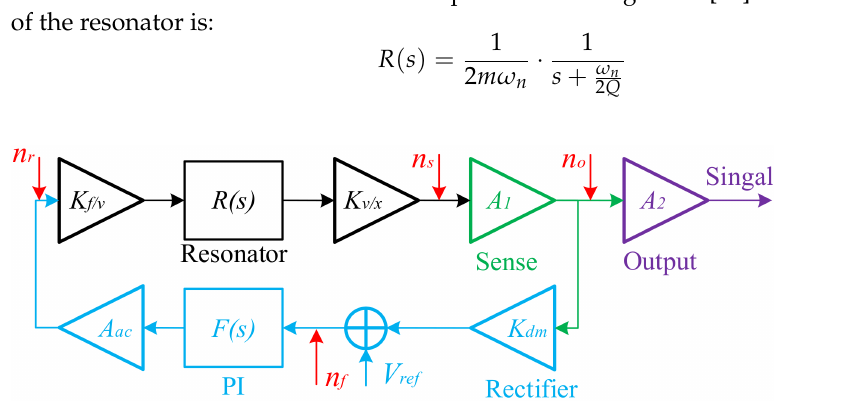
Figure 13. Noise source of x-axis and